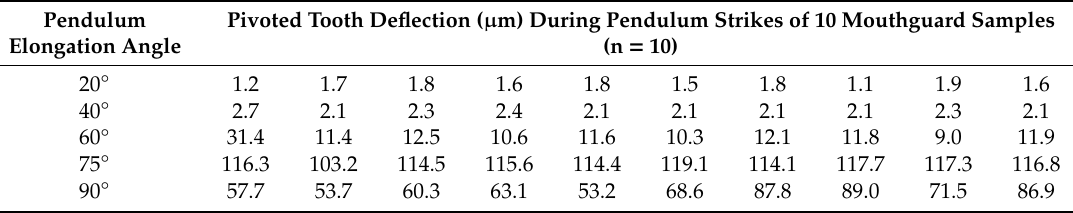
Table 4. Air space / DURAN mouthguard measurements: Average values of maximum amplitudes (mean of 5 measurements per mouthguard and angle) of the pivoted tooth (reflection foil) deflection obtained during measurements with energy blows from 20 ◦ –120 ◦ pendulum elongation angles.